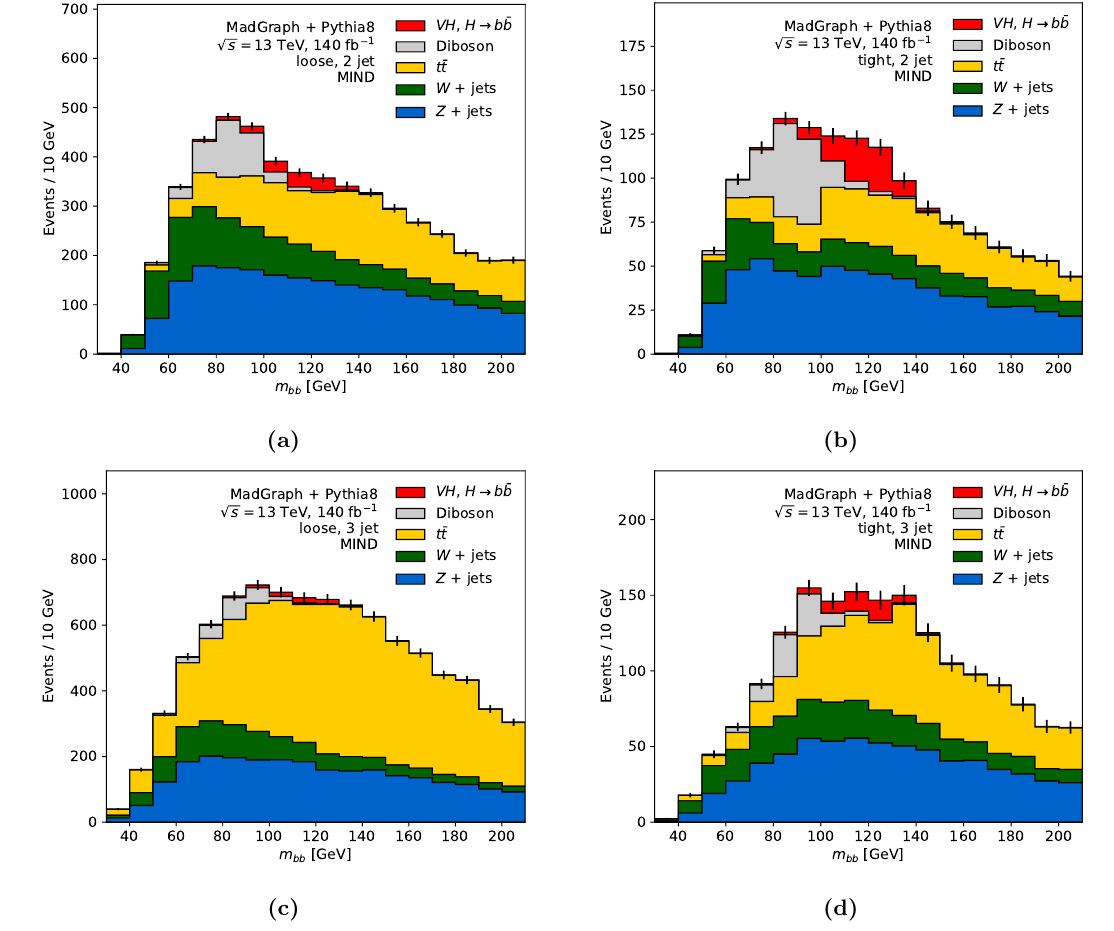
Figure 6 . Analysis categories for a decorrelated classi(cid:12)er trained with MIND and using (cid:21) MIND = 40. The m bb distribution is shown in the two-jet loose (a) and tight (b) categories, as well as three- jet loose (c) and tight (d) categories. Signal events are shown in red, while backgrounds are shown in blue ( Z +jets), green ( W +jets), yellow ( t (cid:22) t ), and gray (diboson). Error bars show the statistical uncertainty on the total MC prediction and are dominated by the uncertainty on the